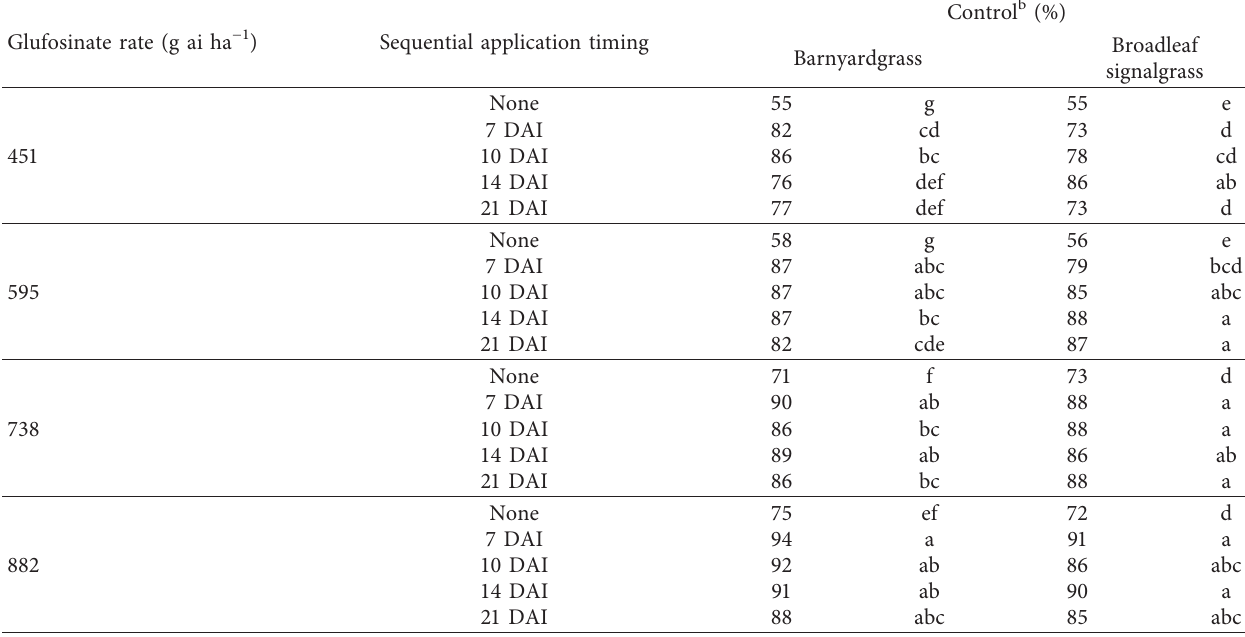
Table 5: An interaction between glufosinate rate and sequential application timing observed on barnyardgrass and broadleaf signalgrass control 3 weeks after the final application in Fayetteville, AR, in 2015, 2016, and 2017.